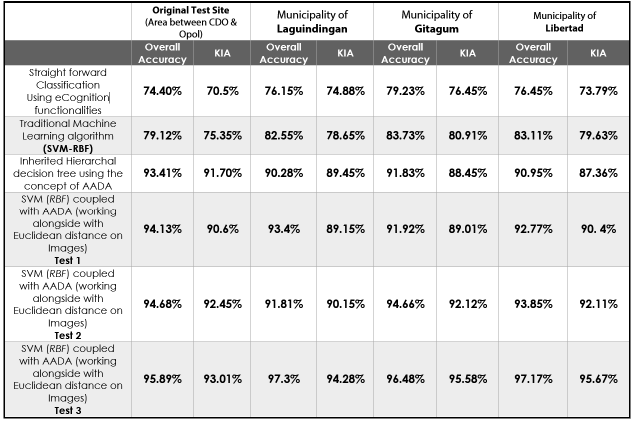
Table 1. Garnered statistics from different classification approach considering different test sites